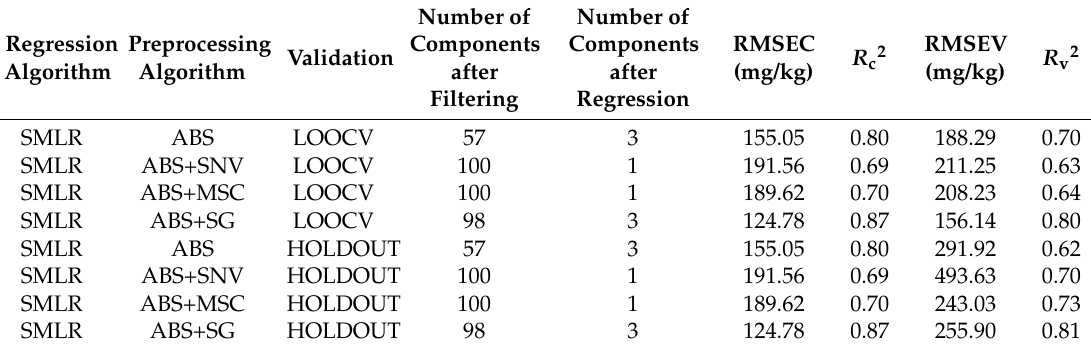
Table 2. Experimental